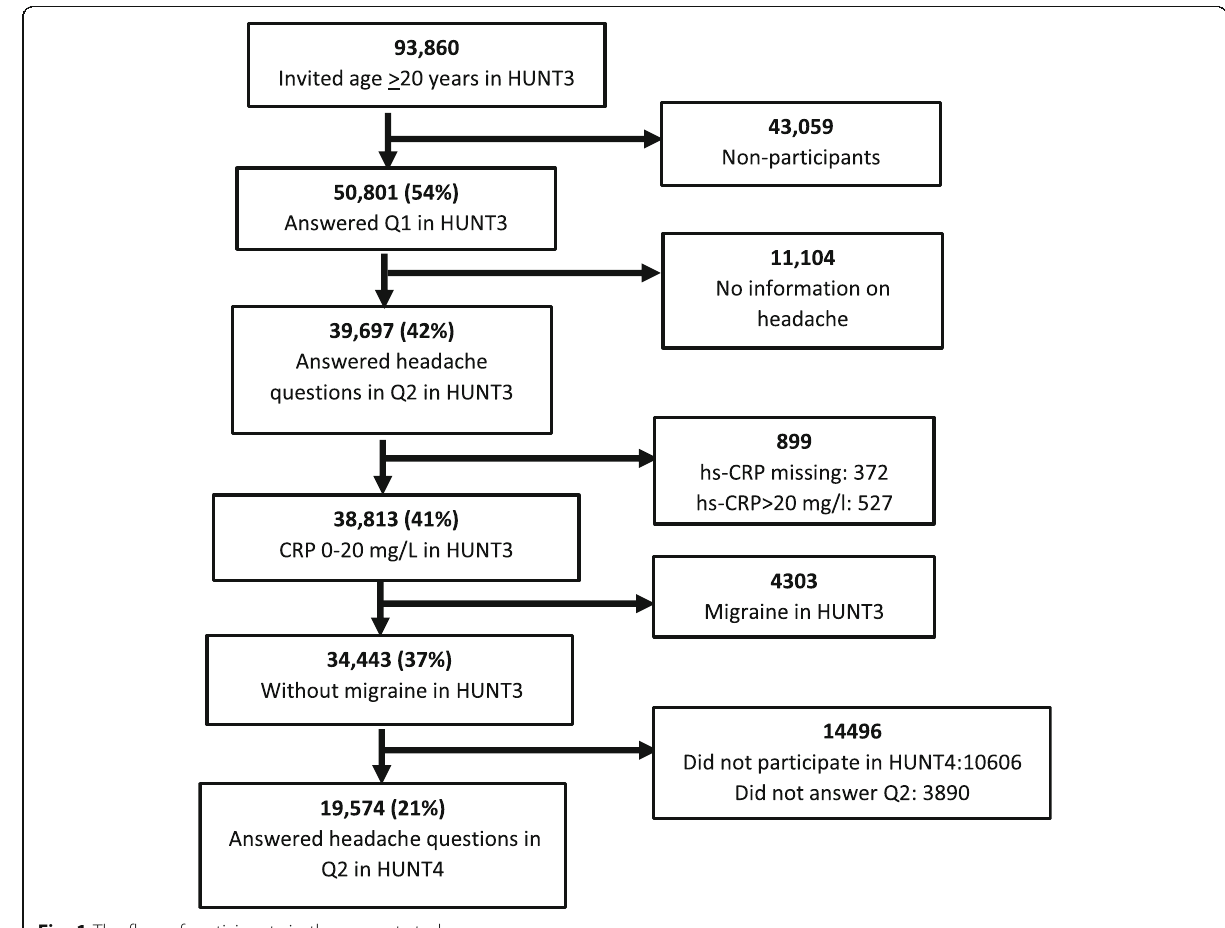
Fig. 1 The flow of participants in the present